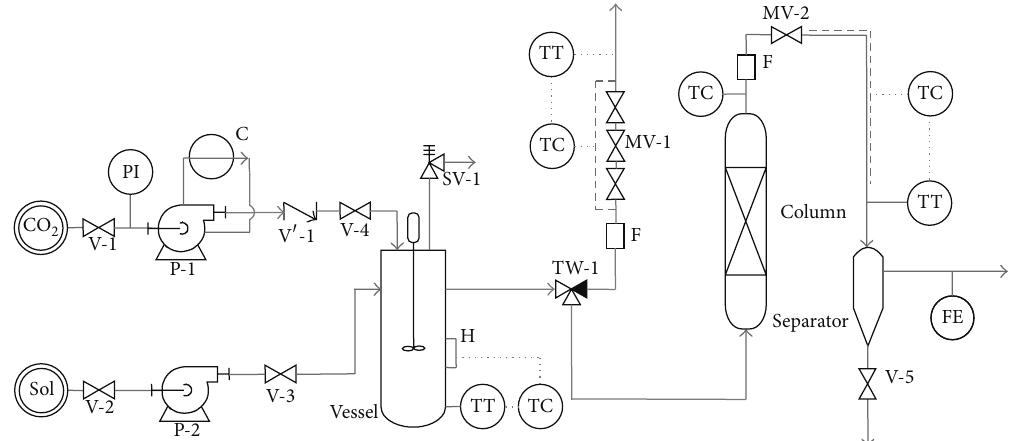
Figure 1: Continuous plant for the adsorption of drugs from supercritical carbon dioxide solutions. P-1, P-2: pumps; C: cooling bath; V 󸀠 -1: one way valve; V-1, V-2, V-3, V-4, V-5: on/off valve; TW-1: three-way valve, SV-1: security valve; H: heater; F: filter; MV-1, MV-2: micrometric valves; FE: rotameter.